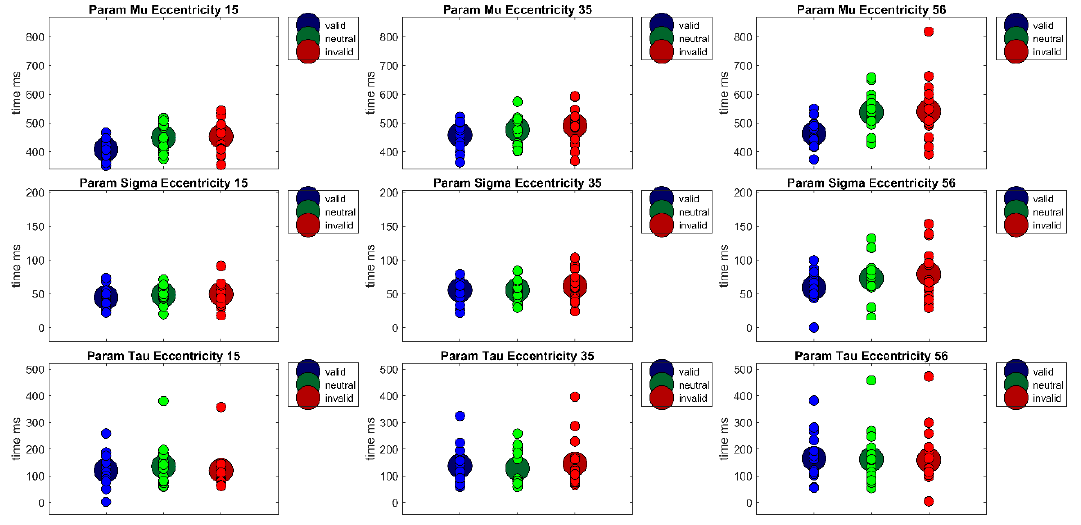
Figure 7. The figure shows the parameters of the ex-Gauss-fit ( μ , σ , τ ) for each Eccentricity (15°, 35°, 56°) × Cueing (valid, neutral, invalid) condition in Experiment 2. Large circles show the condition mean and small circles show the values of each individual participant.